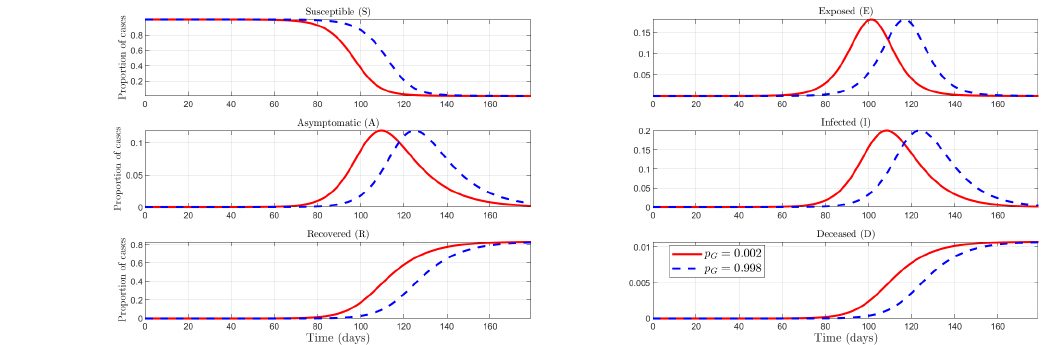
Figure A2. Unexpected vs. Expected